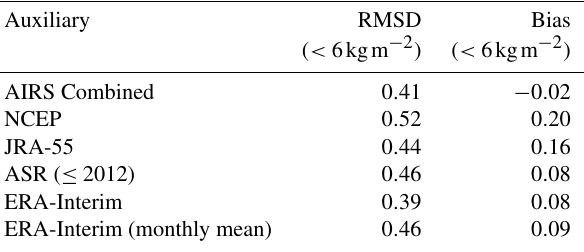
Table 6. Water vapour column root mean square deviations (RMSDs) for PLDC16 retrievals using different auxiliary data sets against GVR measurements for columns less than 6kgm − 2